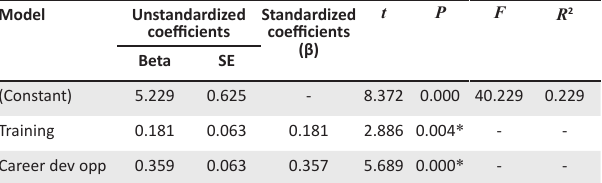
TABLE 4 : Training, and career development opportunities as predictors of affective commitment. Model